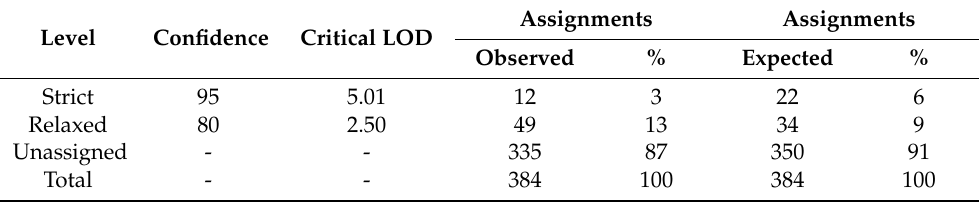
Table 9. Parentage analysis of black sea bream collected from hatcheries (KS_C1) and the wild (ML_W3), with analysis performed using